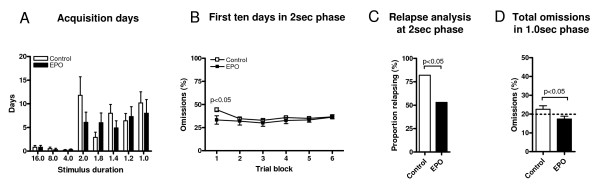
Analysis of selected readouts of cognitive performance in high-performer mice. (A) Number of acquisition days required for reaching performance criteria at each stimulus duration phase shows no group differences but a sharp increase in the transition from 4 sec to 2 sec. (B) The EPO-treated group showed faster task adaptation: The proportion of omissions in the first of six 10-trial blocks collapsed across the first 10 days of the 2-sec phase was significantly lower. Post hoc test. (C) The EPO-treated group showed higher stability of performance: the proportion of mice that relapsed from already reached performance criteria in the 2-sec stimulus duration phase was smaller. Chi2 test. (D) EPO improves performance stability even in the 1-sec phase: Proportion of total omissions over 4 days after reaching performance criteria was significantly lower in the EPO group. Mann-Whitney test. N = 7–28; data presented as mean ± S.E.M.